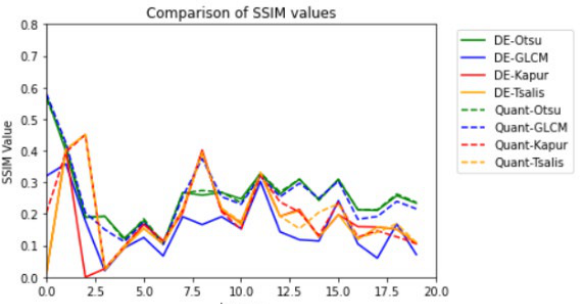
Figure 5 : Comparing SSIM values of various algorithm for 20 different images